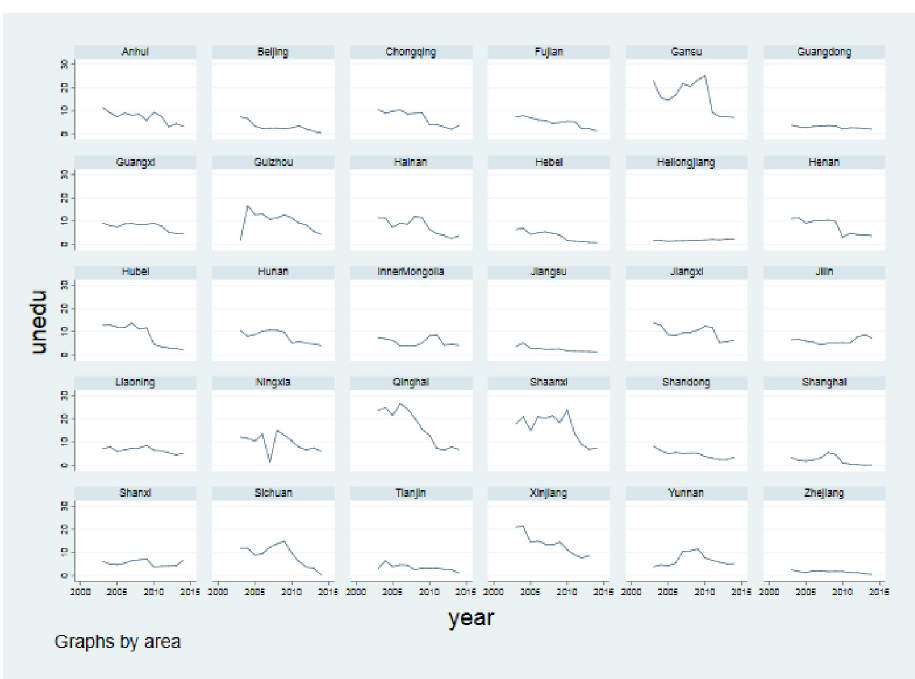
Fig 10. The time trend of the proportion of uneducated RSE children ( Unedu ) in different provinces of China (2003–2014) (Unit: Proportion). Data source are China Rural Statistics Yearbook and the official website of China Disabled Persons’ Federation . Drawn by STATA